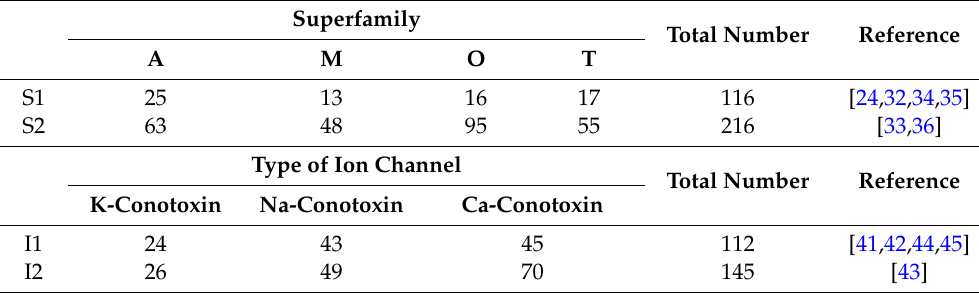
Table 1. The benchmark datasets of conotoxin superfamily and ion channel-targeted conotoxin. Superfamily Total